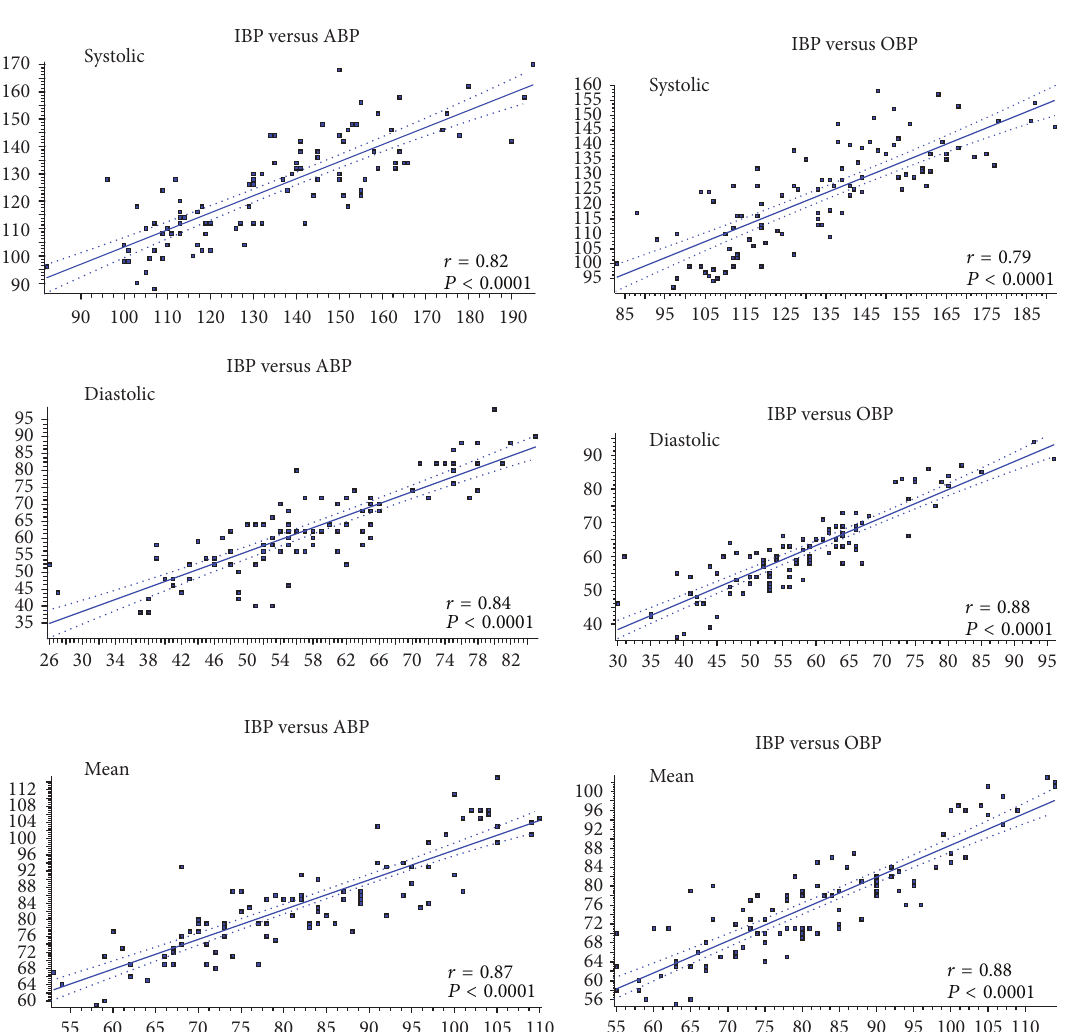
Figure 1: Scatterplot and correlation between systolic, diastolic, and mean blood pressure in comparisons between direct-invasive (IBP) and, respectively, auscultatory-aneroid (ABP) and oscillometric automated (OBP)